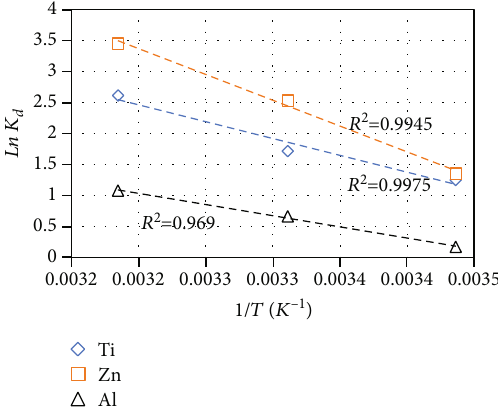
Figure 7: Van ’ t Ho ff plot of the adsorption of Pb(II) onto all adsorbents. Table 4: Thermodynamic parameters for the adsorption of Pb(II) onto all